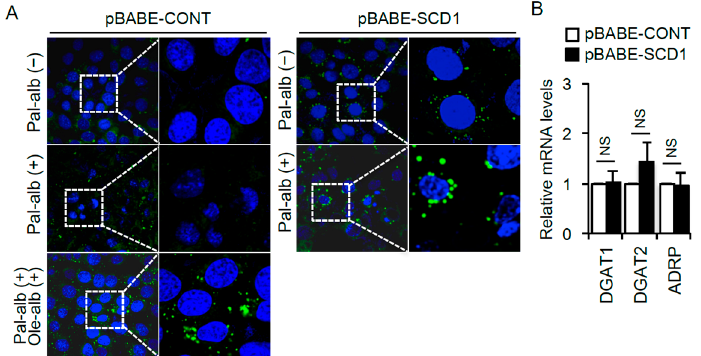
Figure 4. ( A ) Representative BODIPY staining for visualizing intracellular neutral lipid accumulation in cultured proximal tubular cells infected with the control retrovirus (pBABE-CONT) or the retrovirus for SCD1 overexpression (pBABE-SCD1), and treated with/without palmitate or oleate; ( B ) mRNA expression levels of DGAT1 , DGAT2 and ADRP ( n = 6). Data are shown as mean ± SD. NS indicates no significance. DGAT, diacylglycerol transferase; ADRP, adipose differentiation-related protein.